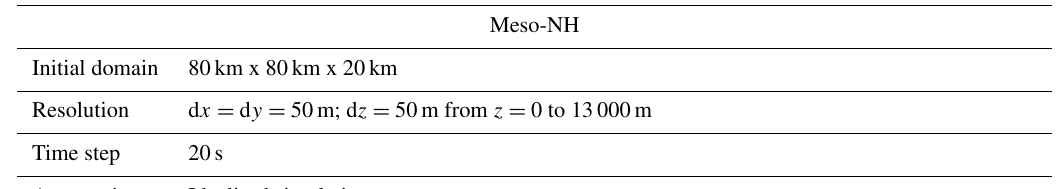
Figure 5. Realistic CLOUD (C3IEL) radiance simulations for a cumulus cloud case and corresponding to acquisitions A1, A6, and A11. The along and across track directions are identified by the x and y arrows, respectively. Table 1. Settings of Meso-NH for the simulations of the deep convective